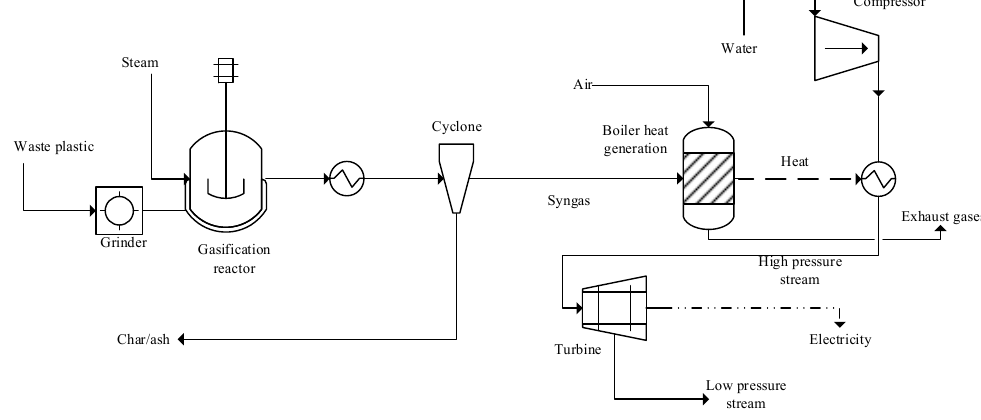
Figure 2. Waste N95 facemask conversion to the heat energy and electrical power (scenario i).